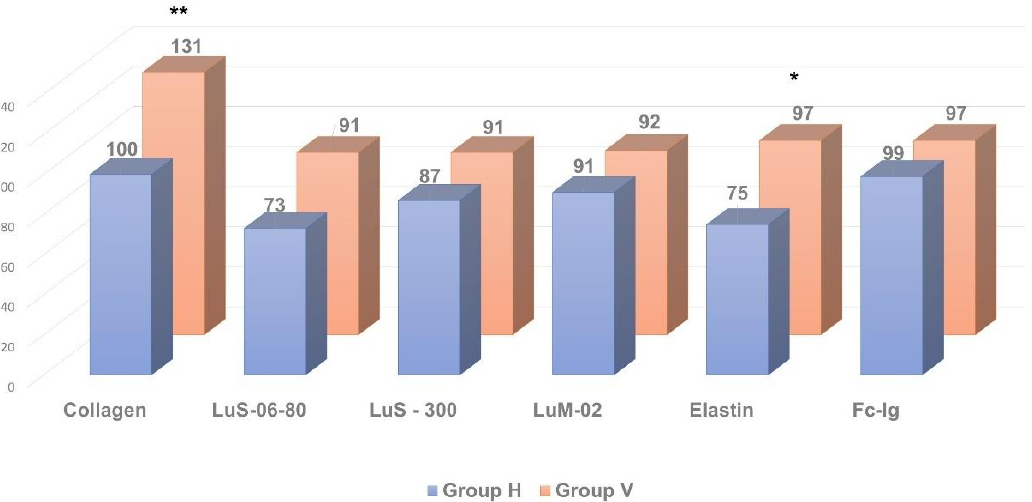
Figure 3. Comparative analysis of anti-pulmonary autoantibody concentration in individuals with clinically significant chronic fatigue of post-viral etiology (group V, n = 13) and healthy individuals (group H, n = 12). * p ≤ 0.05, ** p ≤ 0.01, group V > group H.